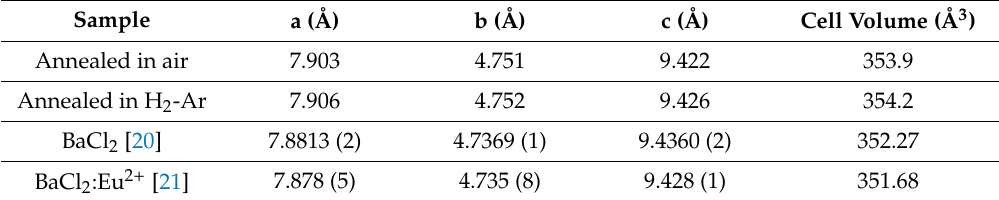
Table 1. The results of the x-ray di ff raction (XRD) pattern analysis of Eu-doped chloroborate glass-ceramic annealed at 570 ◦ C in an air and reducing atmosphere (H 2 –Ar); the lattice parameters for BaCl 2 [20] and BaCl 2 :Eu 2 + nanocrystals [21] are included for comparison.